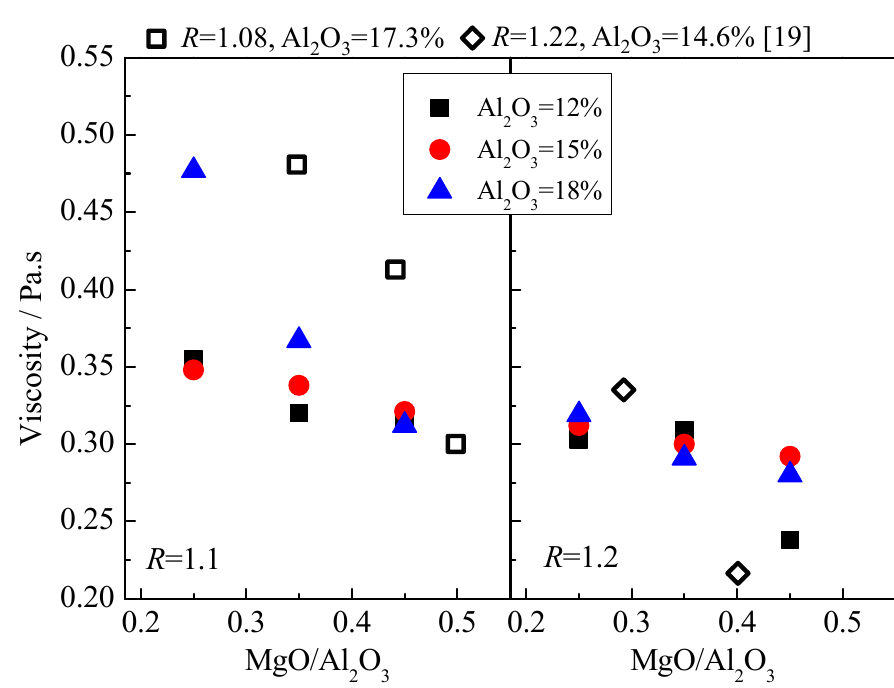
Figure 3. Effect of the MgO/Al 2 O 3 ratio on slag viscosity. Figure 3. E ff ect of the MgO / Al